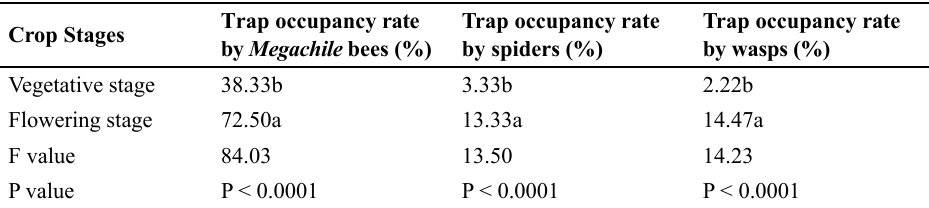
Table 1. Trap occupancy details of leafcutter bees Megachile Latreille, 1802 at two different crop stages of Pigeon pea ( Cajanus cajan (L.) Millsp., Fabaceae) in the experimental farm of ICAR-National Bureau of Agricultural Insect Resources (NBAIR) Bengaluru, Yelahanka Campus, India.